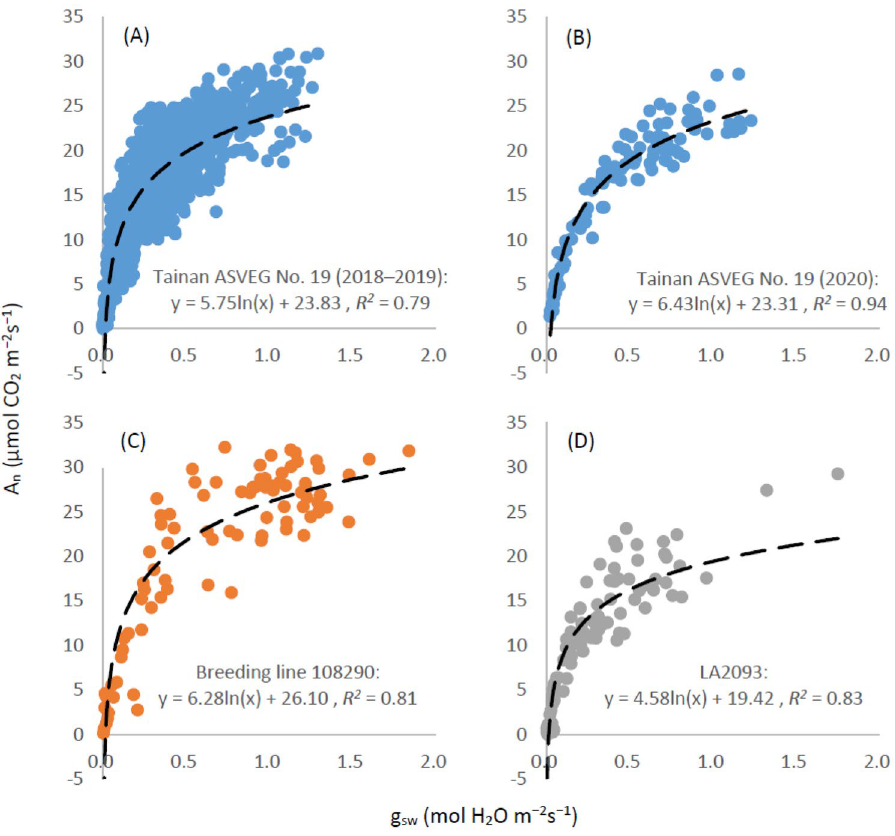
Figure 1. Relationship between light-saturated stomatal conductance (g sw ) and net CO 2 assimilation rate (A n ) of ( A ) Tainan ASVEG No. 19 (2018–2019), ( B ) Tainan ASVEG No. 19 (2020), ( C ) breeding line 108290, and ( D ) LA2093.